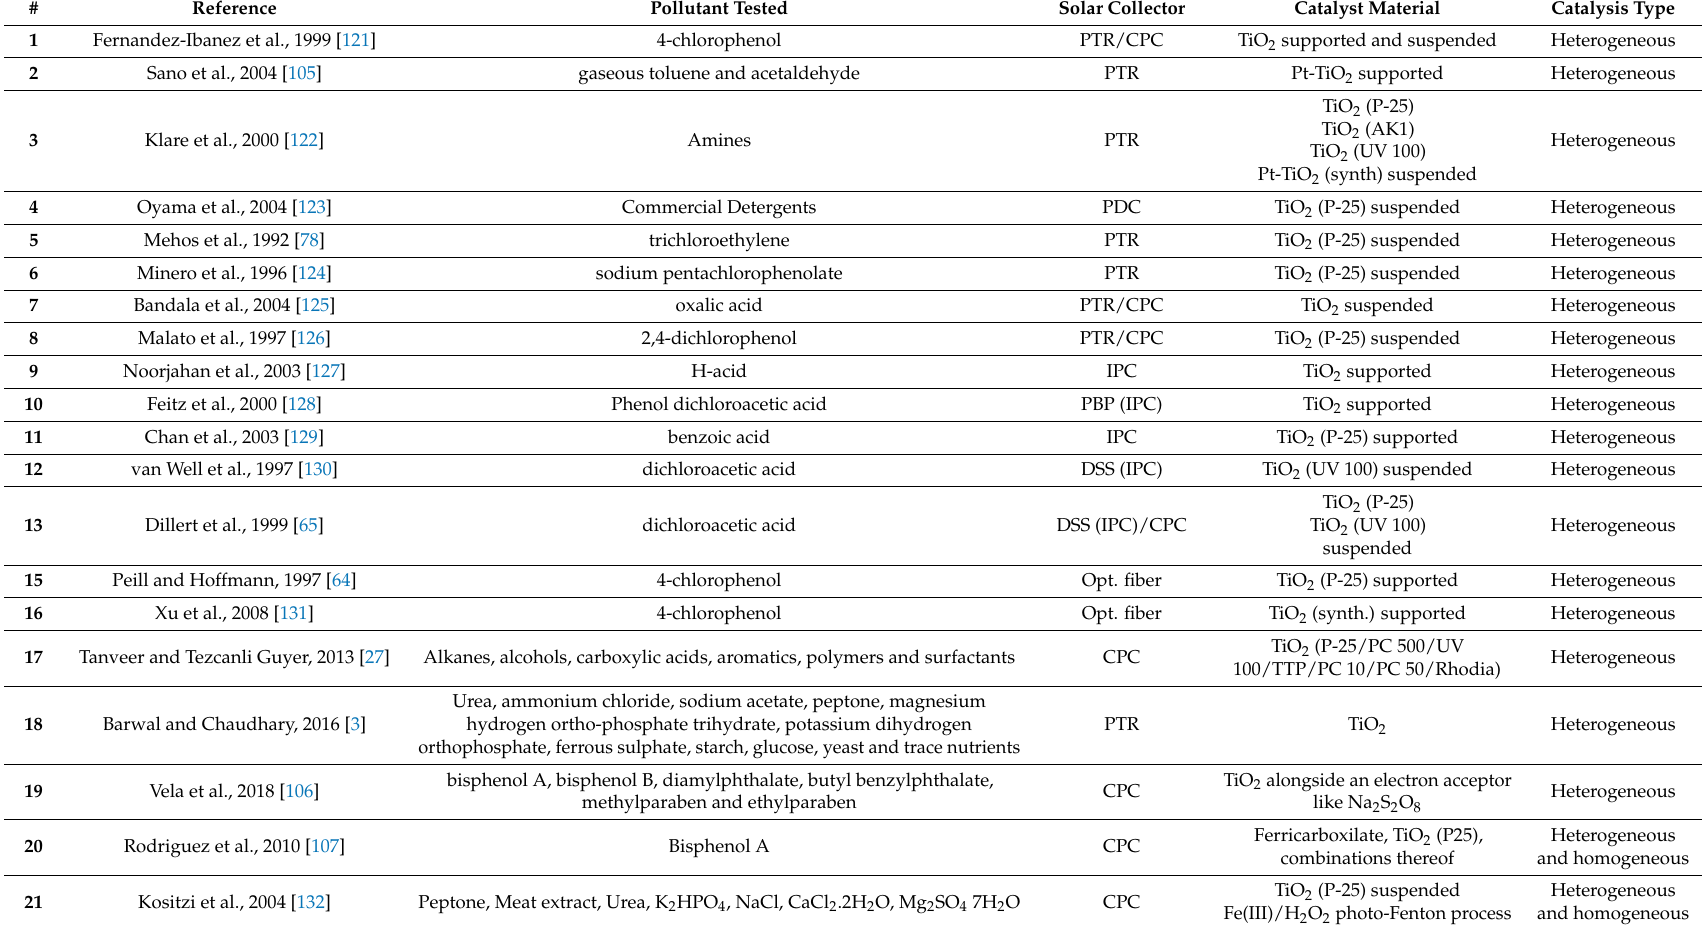
Table 3. BROCs model wastewaters (Industrial general chemical